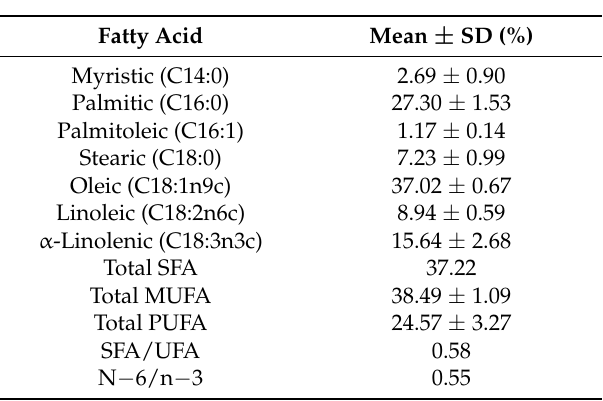
Table 2. Fatty acid composition of L.